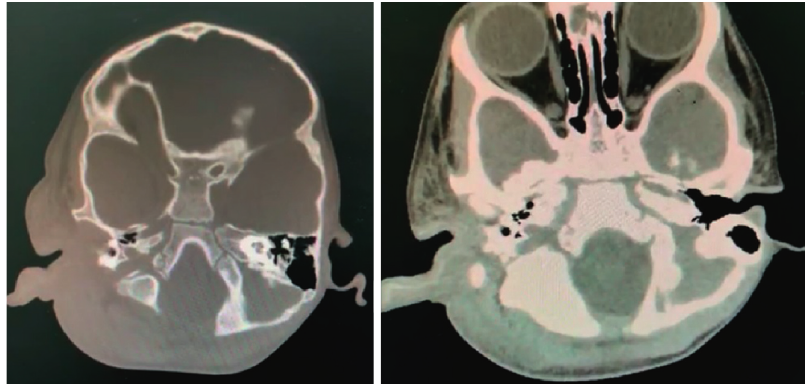
Figure 2: CT scan showing diffuse left side periauricular swelling.